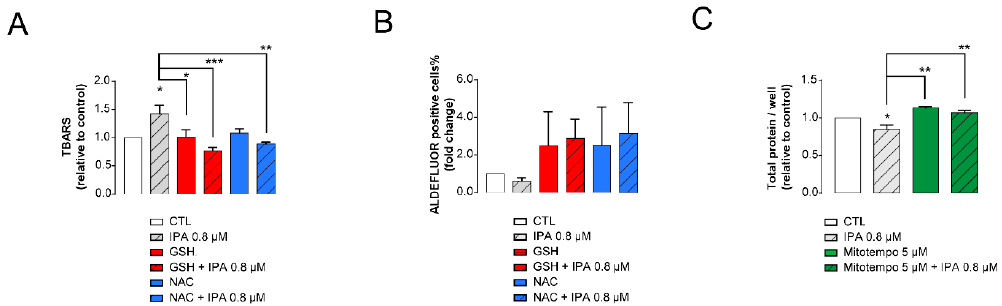
Figure 5. Indolepropionic acid (IPA)-elicited oxidative stress has central role in mediating IPA-elicited antineoplastic e ff ects. 4T1 cells (500,000 cells / well, TBARS; 100,000 cells / well, ALDH; 1500 cells / well, SRB) were treated with IPA in the concentrations indicated for 24 h with or without the antioxidants, as indicated. Subsequently, ( A ) thiobarbituric acid-reactive substances, ( B ) the fraction of Aldefluor-positive cells and ( C ) total protein content was determined. Fold data were log2 transformed to achieve normal distribution. Statistical significance was determined using the ANOVA test followed by Dunnett’s post-hoc test. *, **, and *** indicate statistically significant di ff erence between control and treated samples at p < 0.05, p < 0.01 or p < 0.01, respectively. Abbreviations: TBARS— Thiobarbituric acid-reactive substances, ALDH—Aldehyde dehydrogenase, SRB—Sulforhodamine B,